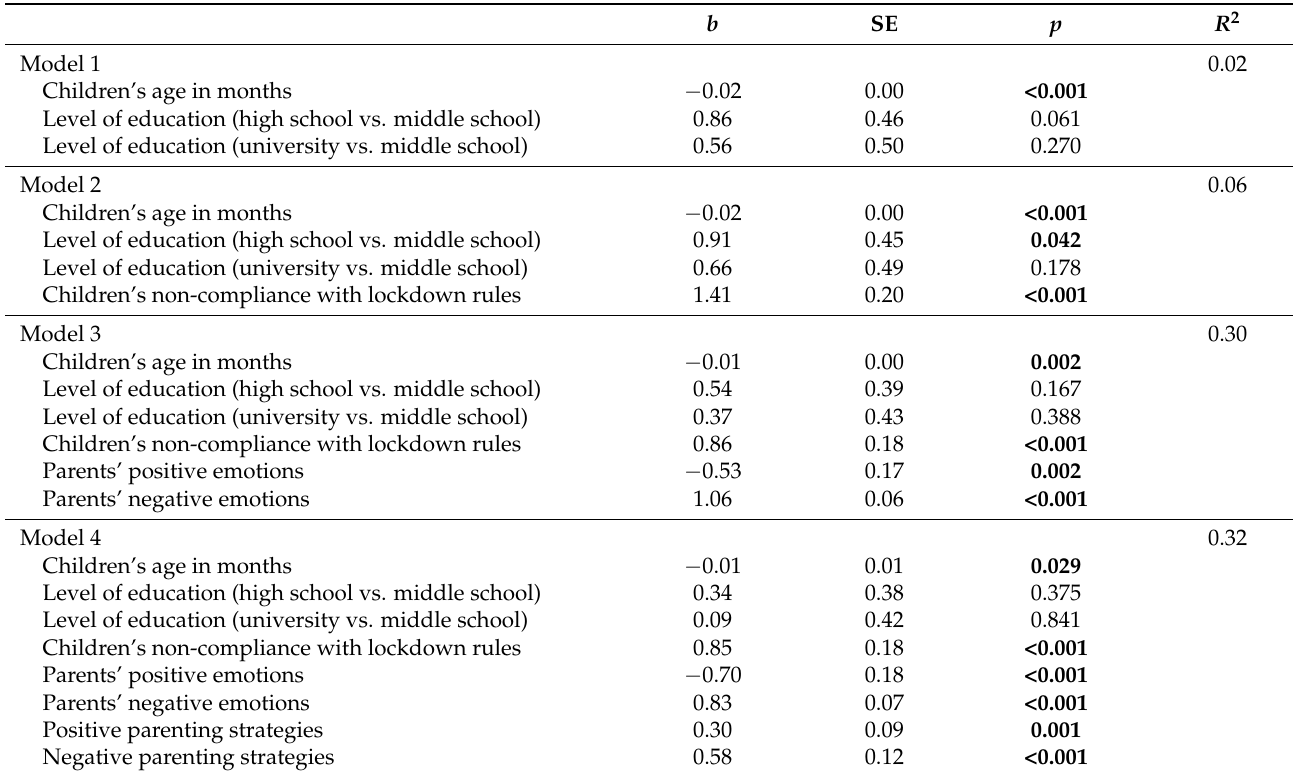
Table 2. Summary of hierarchical regression analysis on children’s externalizing